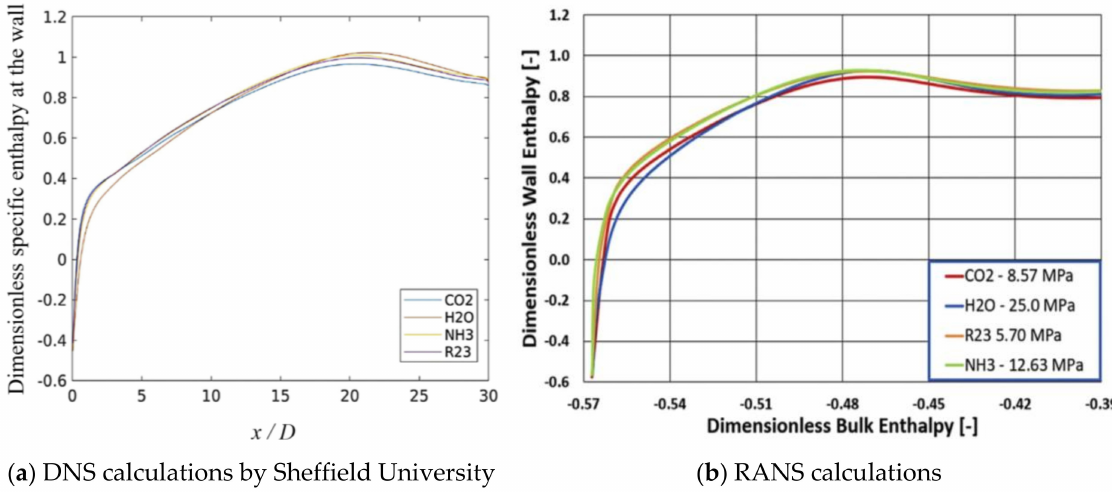
Figure 6. Results from the DNS and RANS calculations in a dimensionless form (adapted from reference